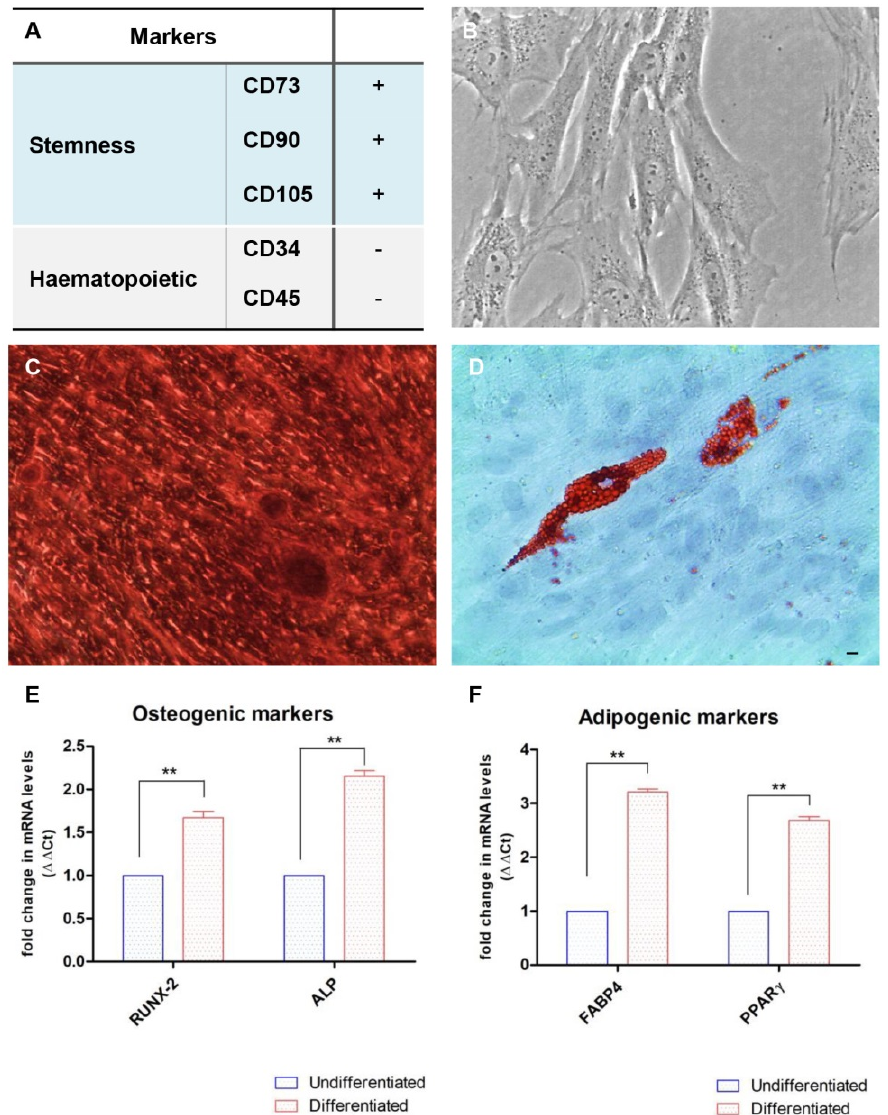
Figure 1. Characterization of human Periodontal Ligament Stem Cells (hPDLSCs). ( A ) Human PDLSCs were positive for CD73, CD90, and CD105, but negative for CD34 and CD45. +: positive expression; -: negative expression. ( B ) Cells were able to adhere on a plastic-substrate with a fibroblast-like morphology. ( C , D ) Human PDLSCs showed their potential to differentiate towards osteogenic (Alizarin Red S staining) and adipogenic (Oil Red O staining) lineages. ( E , F ) Gene expression of osteogenic and adipogenic-related markers. Scale bar: 20 µ m. ** p < 0.01. 2.3. Expression Levels of TLR4/MyD88/NFkB/NLRP3/Caspase-1/IL-1 β in CurLIP and LPS-G Treated